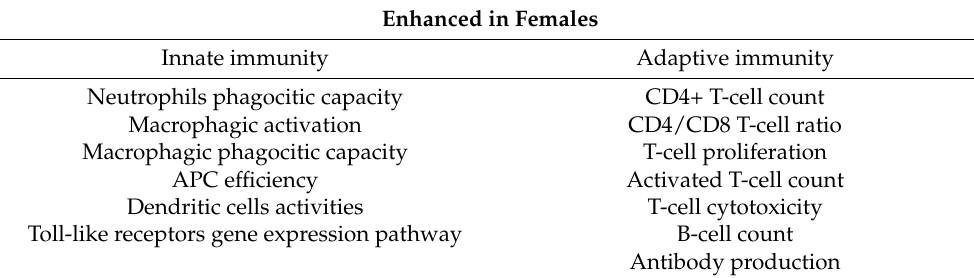
Table 1. Main gender differences in innate and adaptive immunity